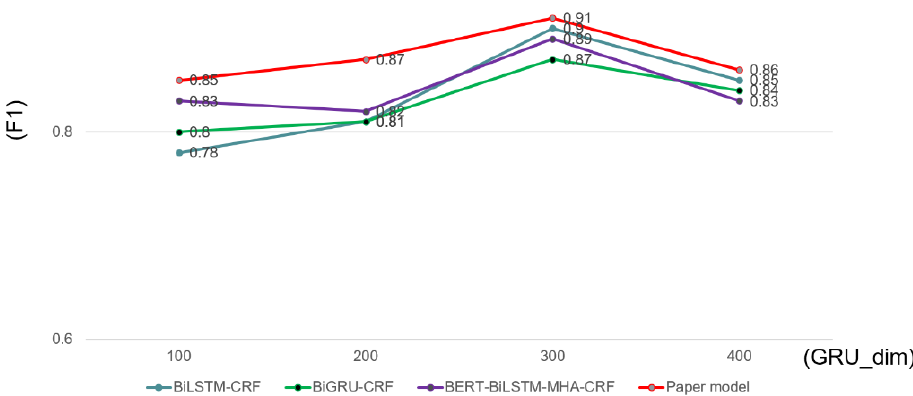
Figure 16. Comparison of entity extraction models experimental results in different dimensions.